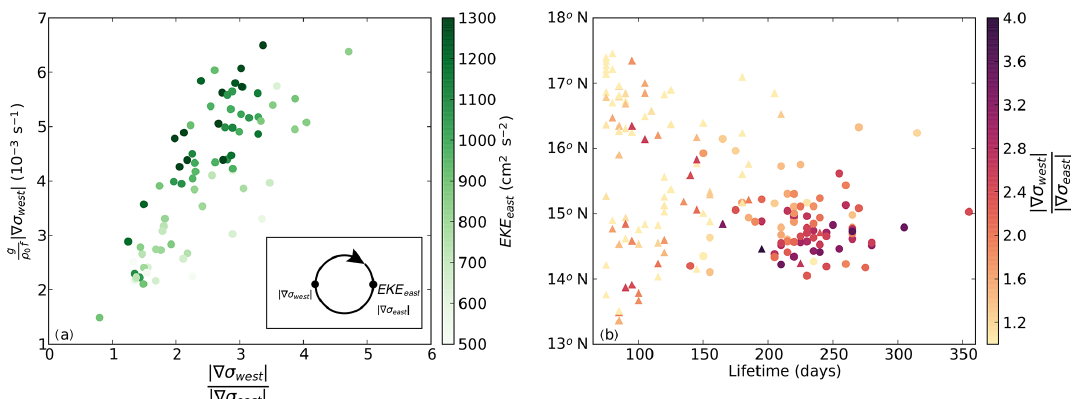
|∇ σ west | Figure 9. (a) Asymmetry of the anticyclones ( |∇ σ east | ) versus the strength of the horizontal temperature gradients on the western side of the anticyclones ( |∇ σ T, west | ) in Ekman100. The asymmetry is defined as the ratio between the strength of the horizontal density gradient on the western and eastern side of the anticyclone between 65 and 75 ◦ W. Colors indicate the EKE of the eastern side of each eddy. Each dot represents one anticyclone, and the inlay contains a schematic of the locations where the properties are calculated. (b) The total lifetime versus latitude of each anticyclone. Anticyclones with long tracks (black lines in Fig. 6a) are indicated with dots, and anticyclones with short tracks (grey lines in Fig. 6a) are indicated with triangles. Colors denote the asymmetry of the anticyclones. All properties are calculated as average values between 65 and 75 ◦ W from individual anticyclones in all